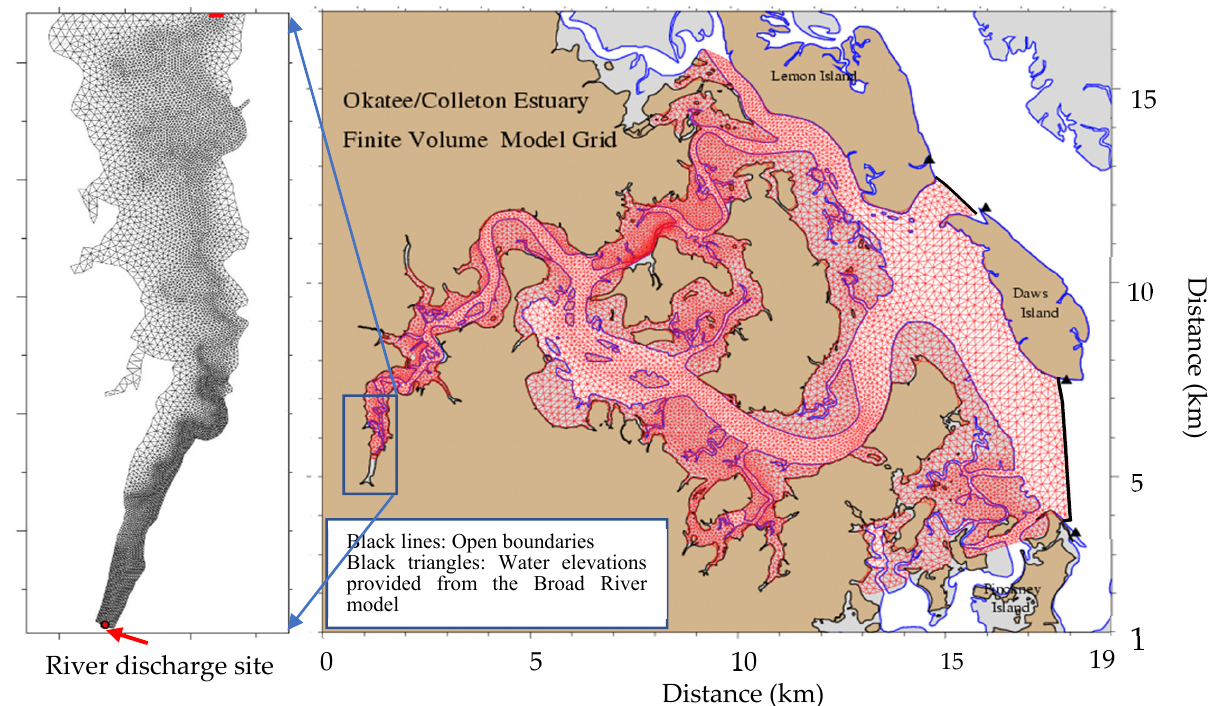
Figure 3. The unstructured grid of the nested OCRE-FVCOM and OTC-FVCOM. The total mesh numbers are 14,422 for the OCRE-FVCOM, and 13,926 for the OTC-FVCOM. In the OCRE-FVCOM, the horizontal resolution ranges from ~250 m in the main channel of the estuary to ~25 m in the upstream area. In the OTC-FVCOM, the horizontal resolution varies from ~5 m in the main river channel to ~10 m on the surrounding intertidal saltmarsh. The box in the right panel is the sub-domain of the OTC-FVCOM. Black heavy lines indicate the open boundaries for the OCRE-FVCOM. The OCRE-FVCOM was driven by the tidal forcing at two open boundaries